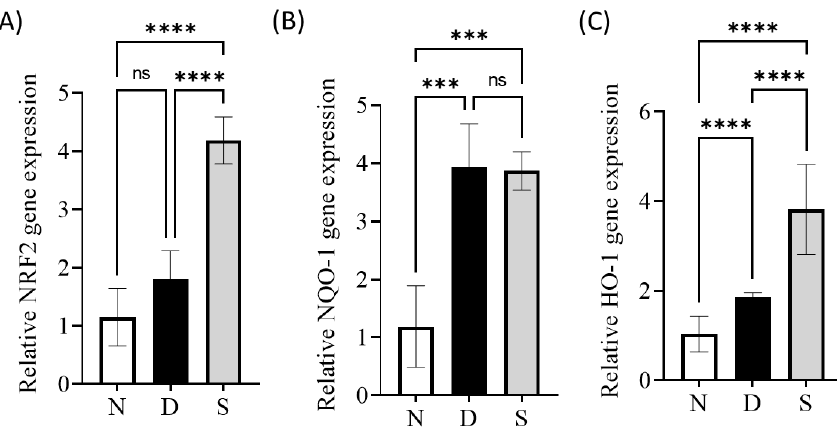
Figure 5. Effect of Swietenine on Nrf2, NQO-1 and HO-1 gene expression with respect to the reference gene. N, normal group; D, diabetic mice group; S, treatment with swietenine (80 mg/kg) group. ( A ) The levels of NRF2 in the normal and diabetic groups were insignificant. However, there was a 20-fold increase after the diabetic mice were treated with swietenine. ( B ) NQO1 and ( C ) HO-1 levels slightly increased in the diabetic group compared to those in normal mice. The treatment with Swietenine upregulated the NQO1 and HO-1 by close to 20-fold. ns: Not significant;, *** p < 0.001, **** p < 0.0001.